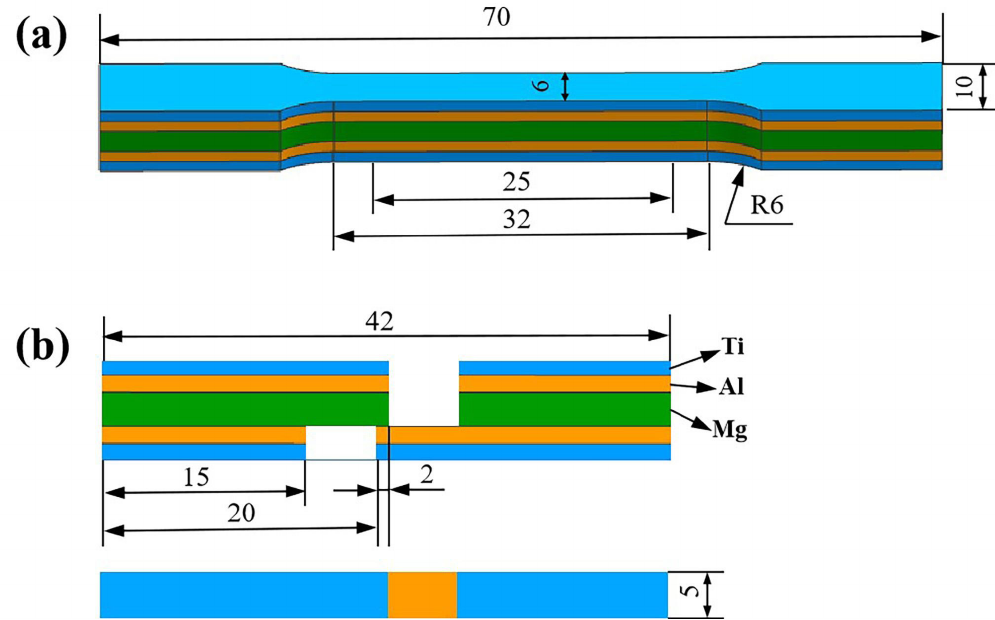
Figure 4. The schematic diagrams of specimens for (a) uniaxial tensile tests and (b) shear